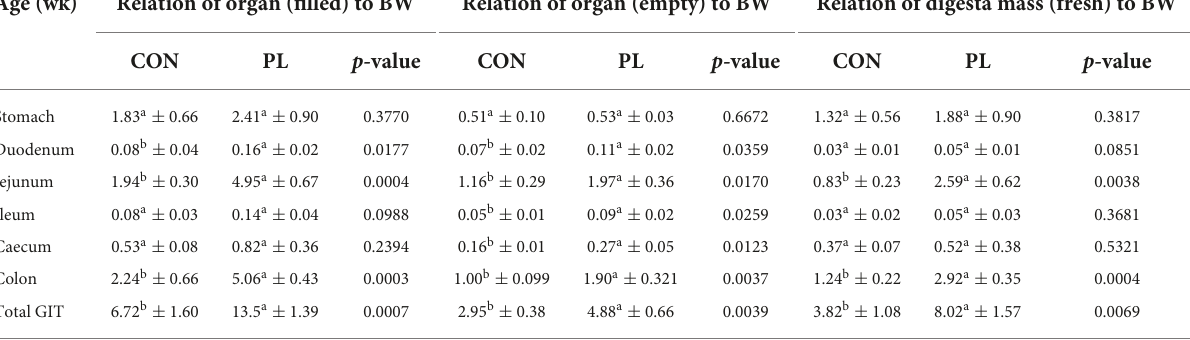
TABLE 6 Relation (%) of the masses of stomach as well as intestinal segments (filled or empty) and of digesta mass (fresh) to the body weight (BW) of the animals in both groups at the time of dissection (mean ± SD). Age (wk)